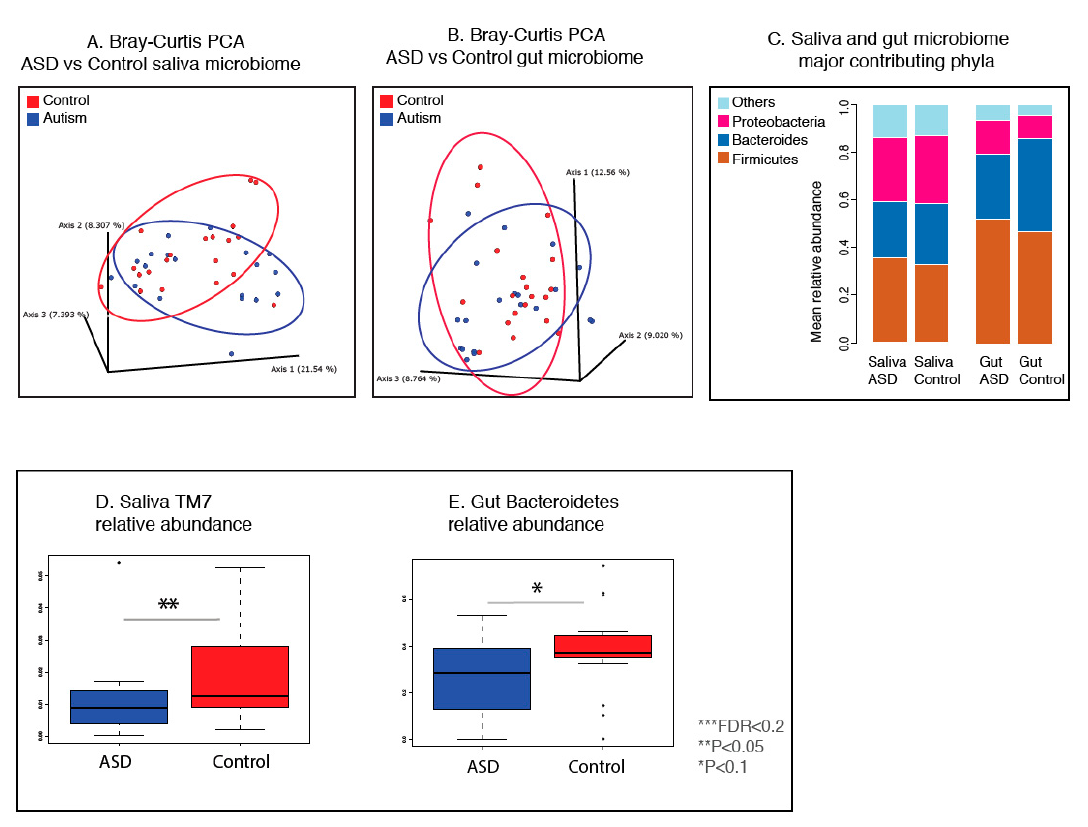
Figure 2. PCA of bacterial beta diversity of saliva ( A ) and gut ( B ) microbiomes based on the Bray–Curtis dissimilarity for ASD and neurotypical subjects. ASD and neurotypical subjects are colored in blue and red, respectively. ( C ) The major contributing phyla of gut and oral microbiome, in ASD and control subjects. The values used to compose the figures represent group mean relative abundances. ( D , E ) Box plots depicting relative abundances of the most differentially abundant salivary or gut bacterial phyla between patients with ASD and control subjects. Single asterisk indicates p < 0.1 with adjusted FDR > 0.2; double asterisk indicates p < 0.05 with adjusted FDR > 0.2, triple asterisk indicates p < 0.05 and adjusted FDR < 0.2, Kruskal–Wallis test.